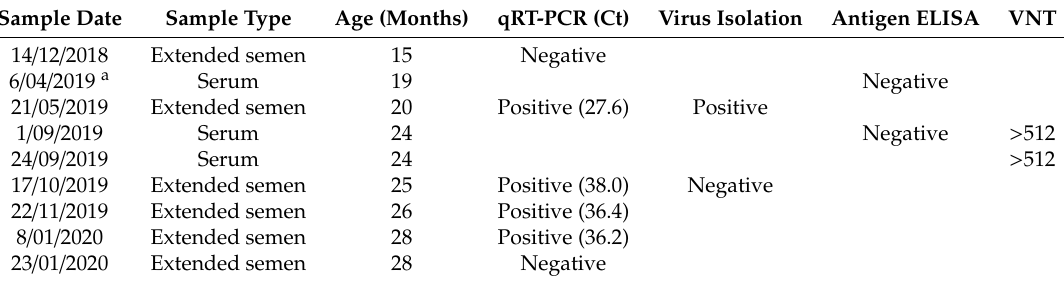
Table A6. Serological and virological test results for Bull